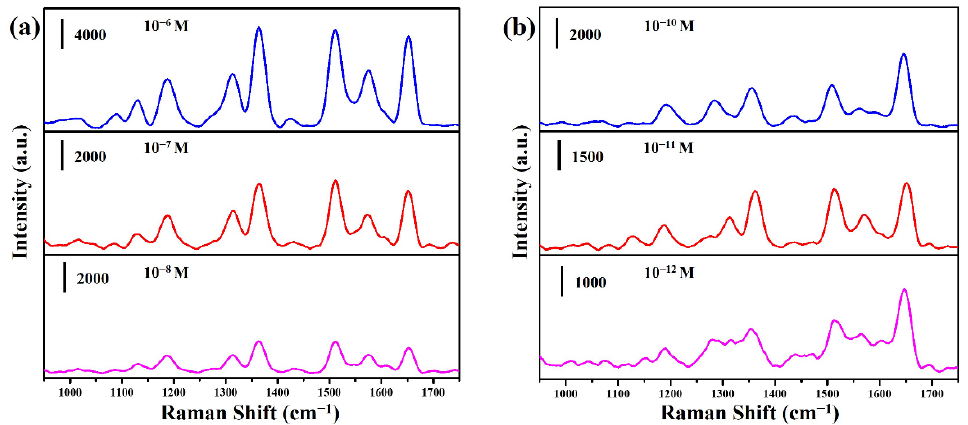
Figure 8. SERS spectra of R6G at different concentrations were obtained from ( a ) CuO@Ag nanowires and ( b ) CuO@RF@Ag nanowires.